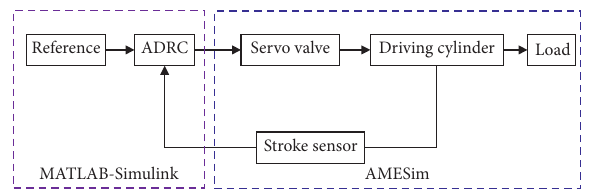
Figure 4: Schematic diagram of cosimulation principle.